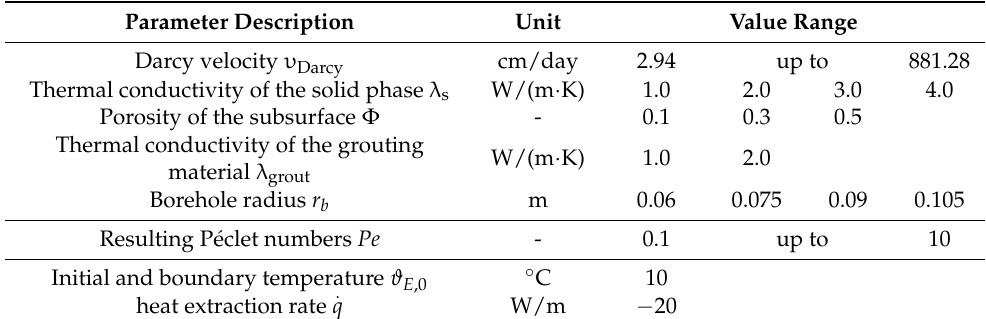
Table 1. Examined parameter ranges for the comparison between the numerical model and the infinite